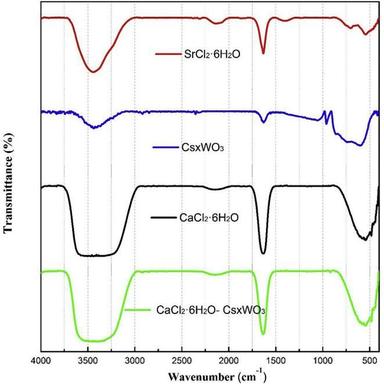
FT-IR spectrum CaCl2·6H2O, SrCl2·6H2O, CsxWO3 nanoparticles and CaCl2·6H2O with different mass ratio of CsxWO3 nanoparticles.